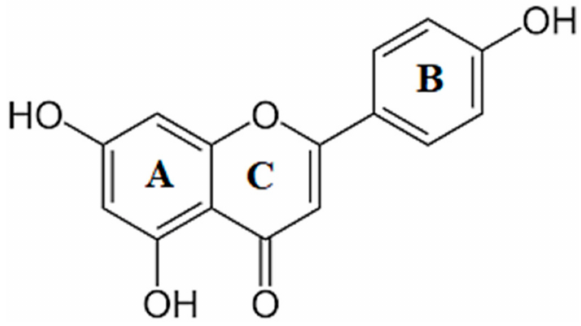
Figure 1. Chemical structure of